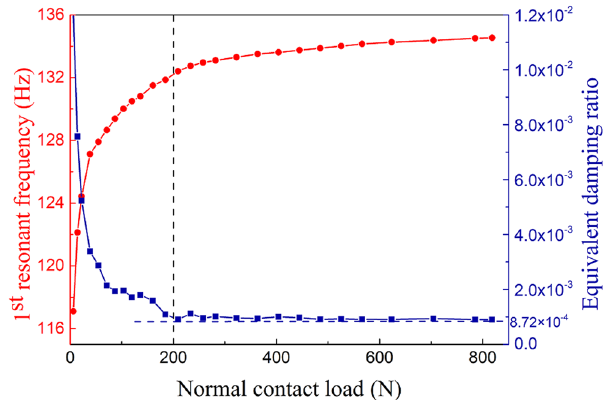
Figure 2. Variations of the resonant frequency and the equivalent damping ratio versus the normal contact load.